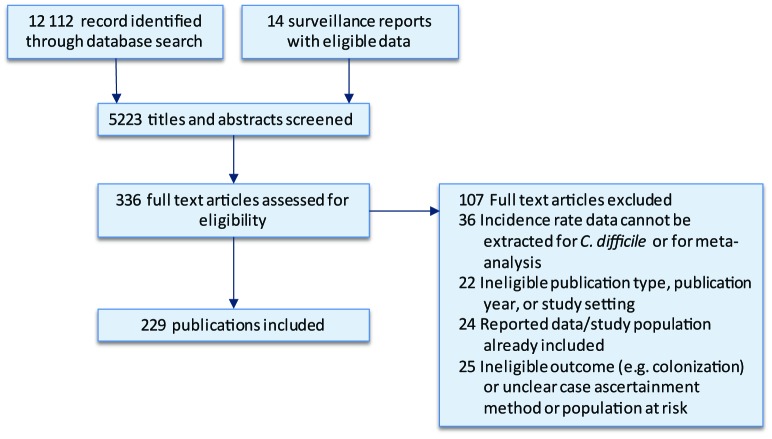
PRISMA flowchart.